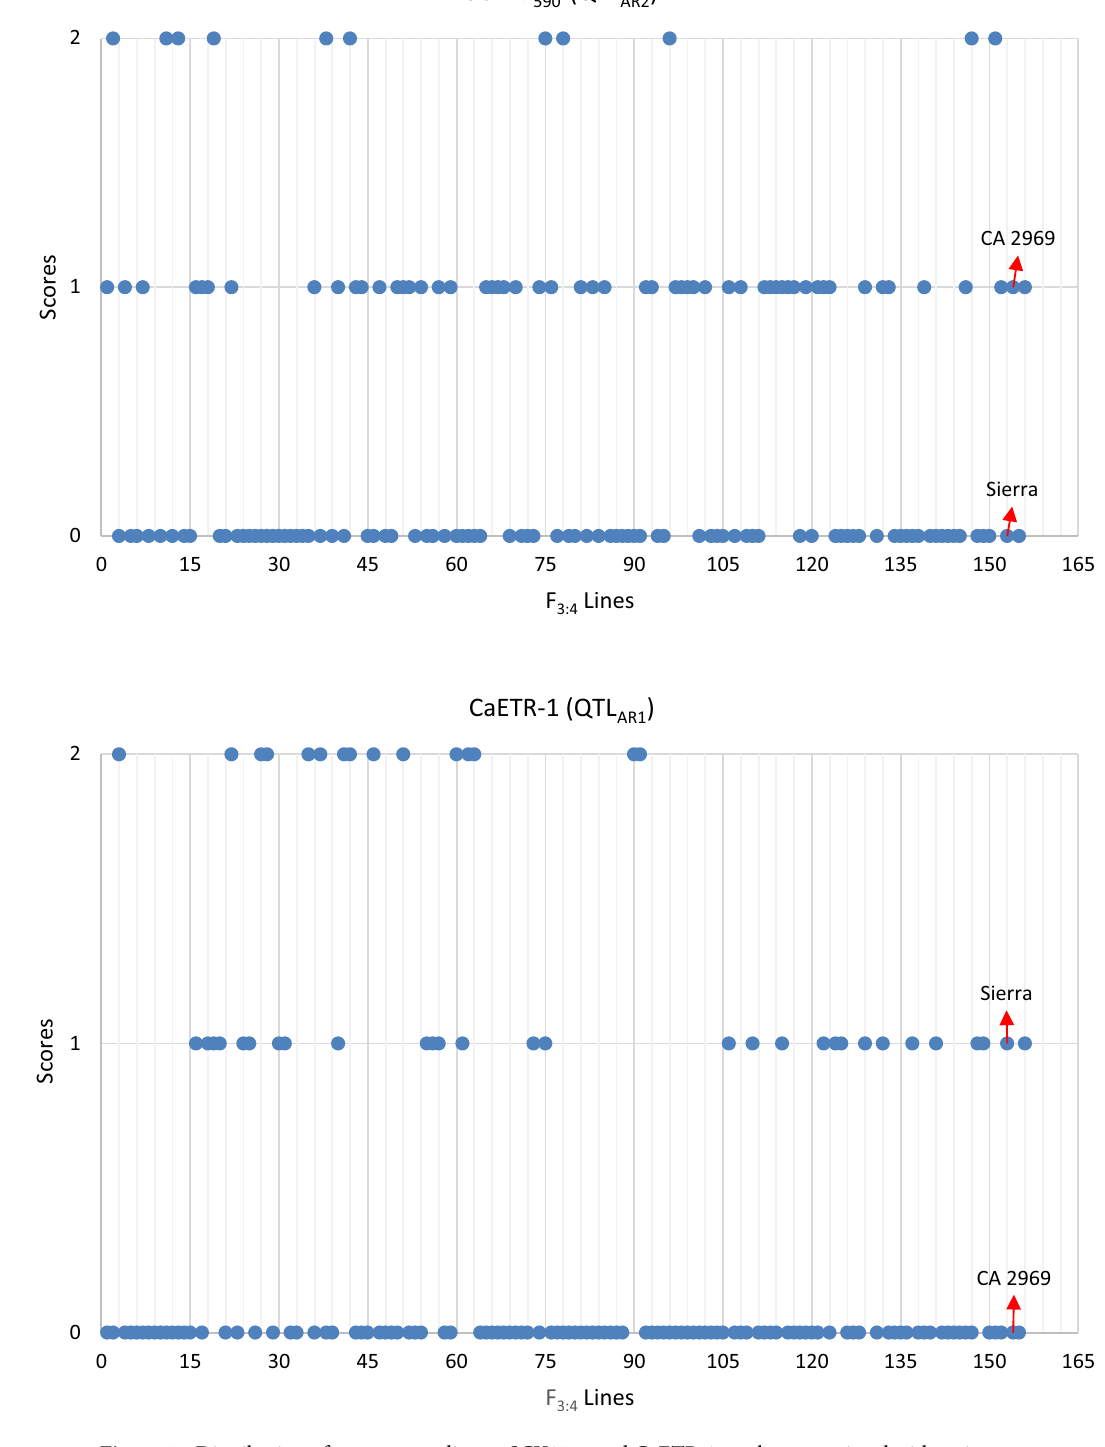
Figure 5. Distribution of scores according to SCY17 590 and CaETR-1 markers associated with resistance to ascochyta blight in 152 F 3:4 lines. (0: Homozygous susceptible, 1: Homozygous resistant, 2: